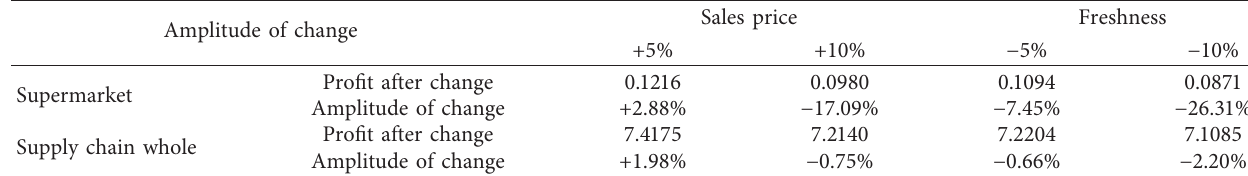
Table 9: Sensitivity analysis results-changes in sales price and